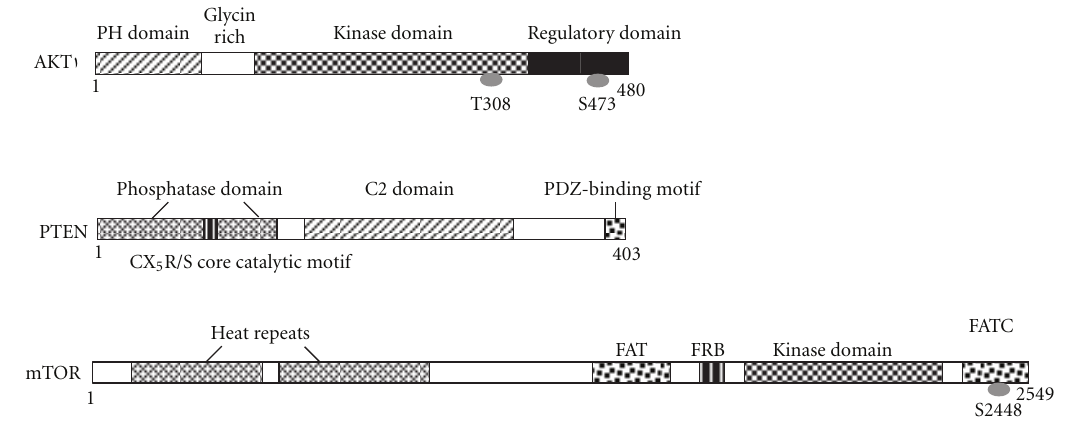
Figure 2: Schematic structures of AKT1, PTEN, and mTOR protein. The predicted consensual domain structures for each protein are depicted. The functionally important sites including the sites of protein phosphorylation are also shown. Note that the sizes of protein are modified for clarity. PH domain: pleckstrin homology domain; C2 domain: a protein structural domain involved in targeting proteins to cell membranes; PDZ: a common structural domain in signaling proteins (PSD95, Dlg, ZO-1, etc.); HEAT: huntington, elongation factor 3, a subunit of PP2A, and TOR1; FAT: FRAP-ATM-TRRAP; FRB: FKBP12-rapamycin binding; FATC: